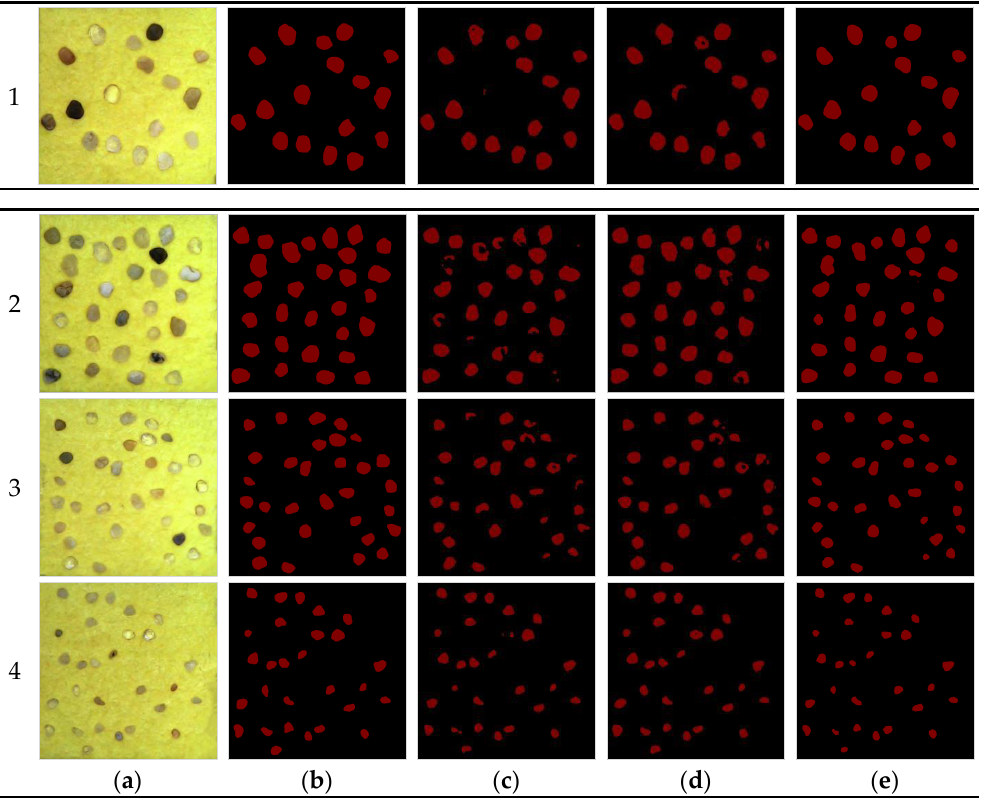
Table 3. Objective evaluation index of each